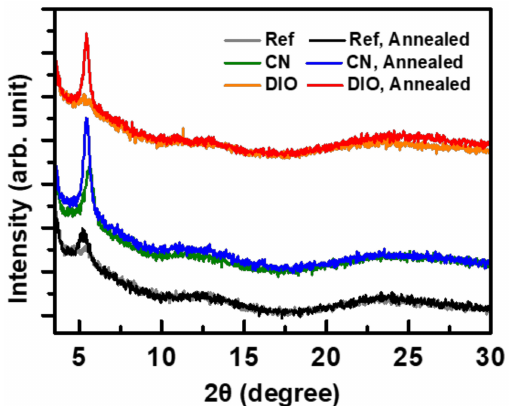
Figure 6. XRD profiles of P3HT thin films with/without additives and before/after thermal annealing at 120 ◦ C for 30